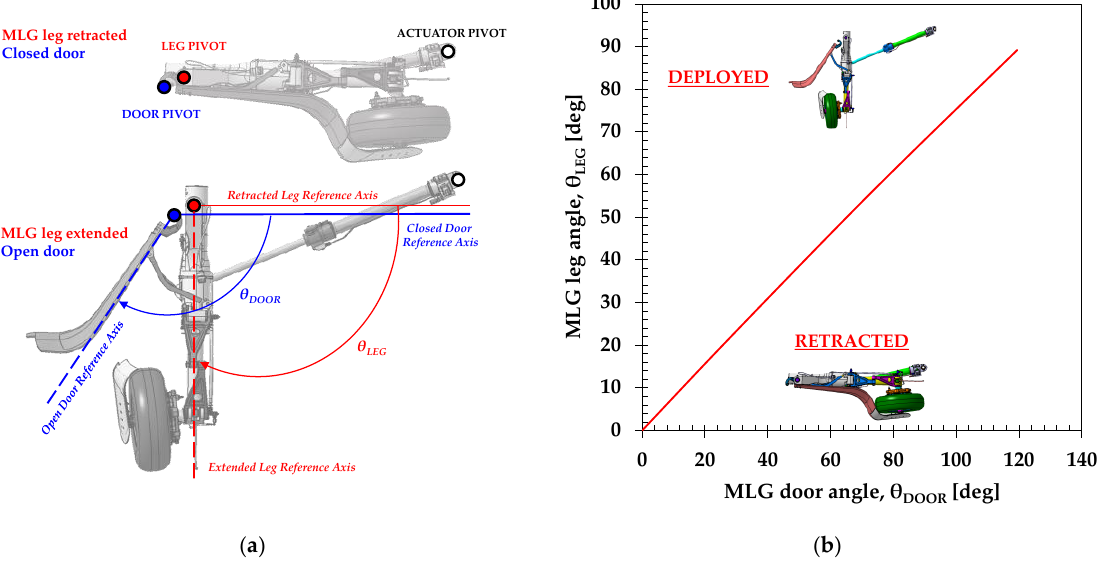
Figure 3. Kinematic deployment of the MLG system: ( a ) details of the relative angles and rotation points; ( b ) gear ratio relationship.